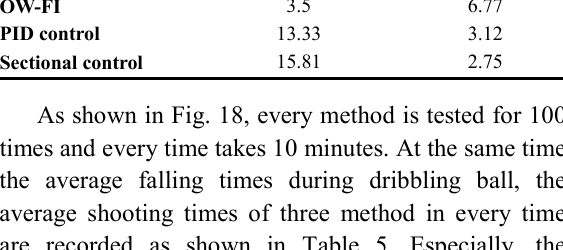
Fig. 16. Target tracking comparison of three methods. (a) Average tracking trajectory of OW-FI. (b) Average tracking trajectory of PID control. (c) Average tracking trajectory of sectional control.